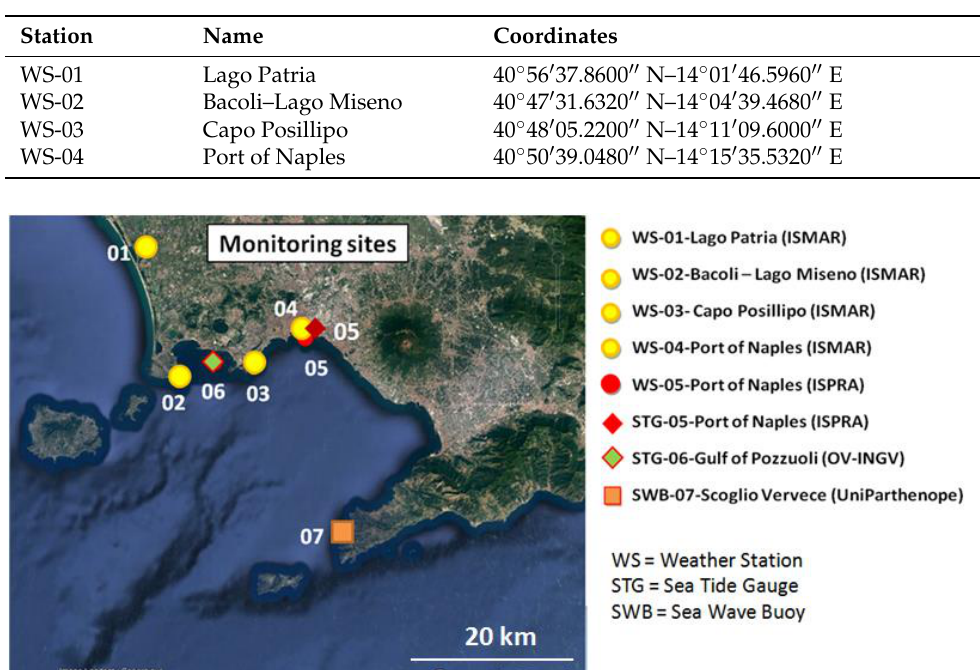
Table 1. List of the CNR-ISMAR weather stations (WS).